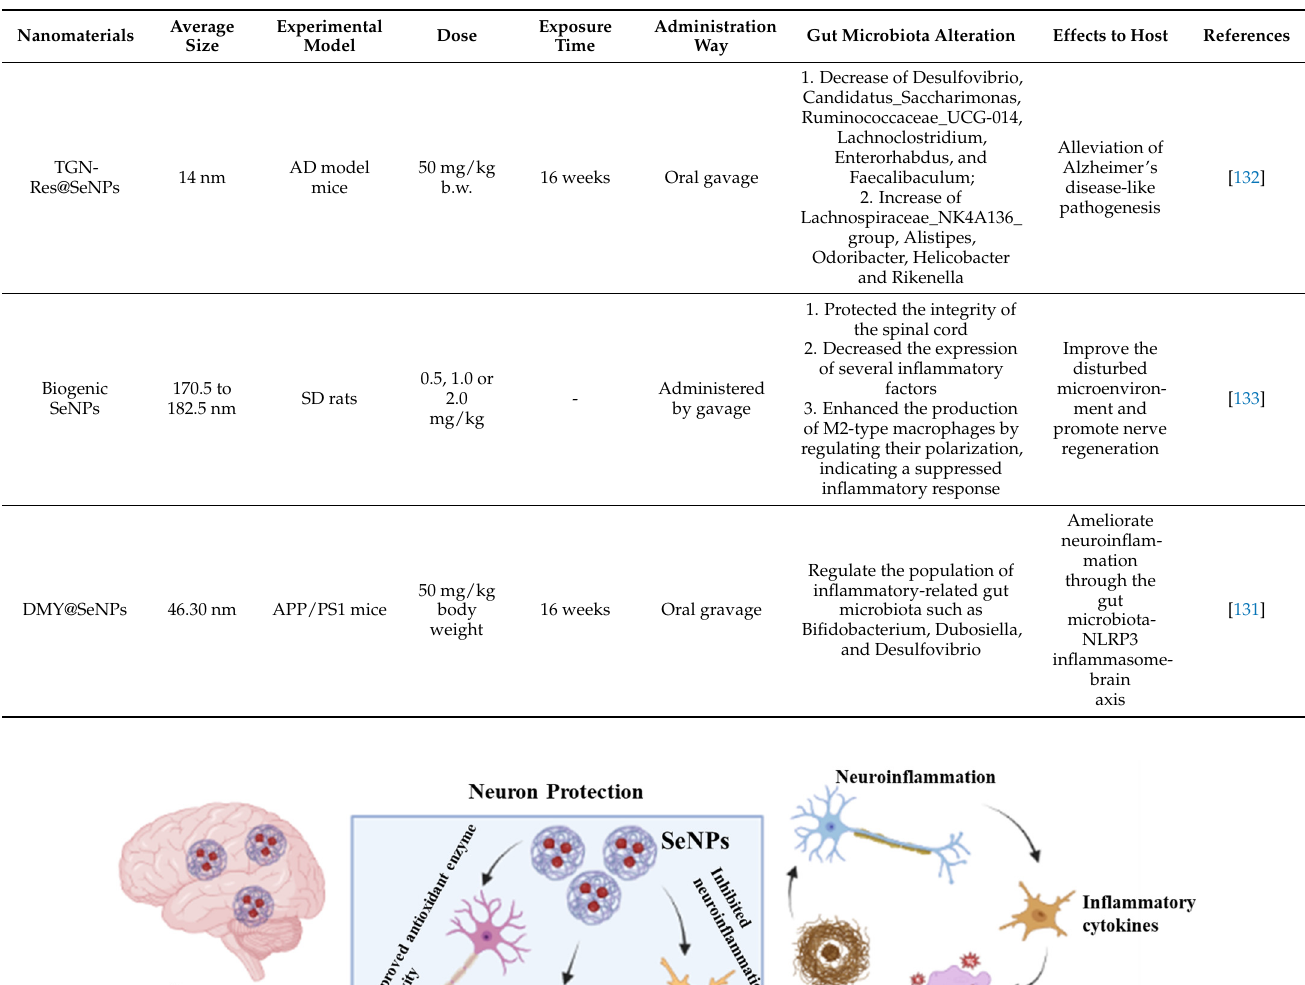
Table 3. Effect of SeNPs on neurological diseases and microbiota.